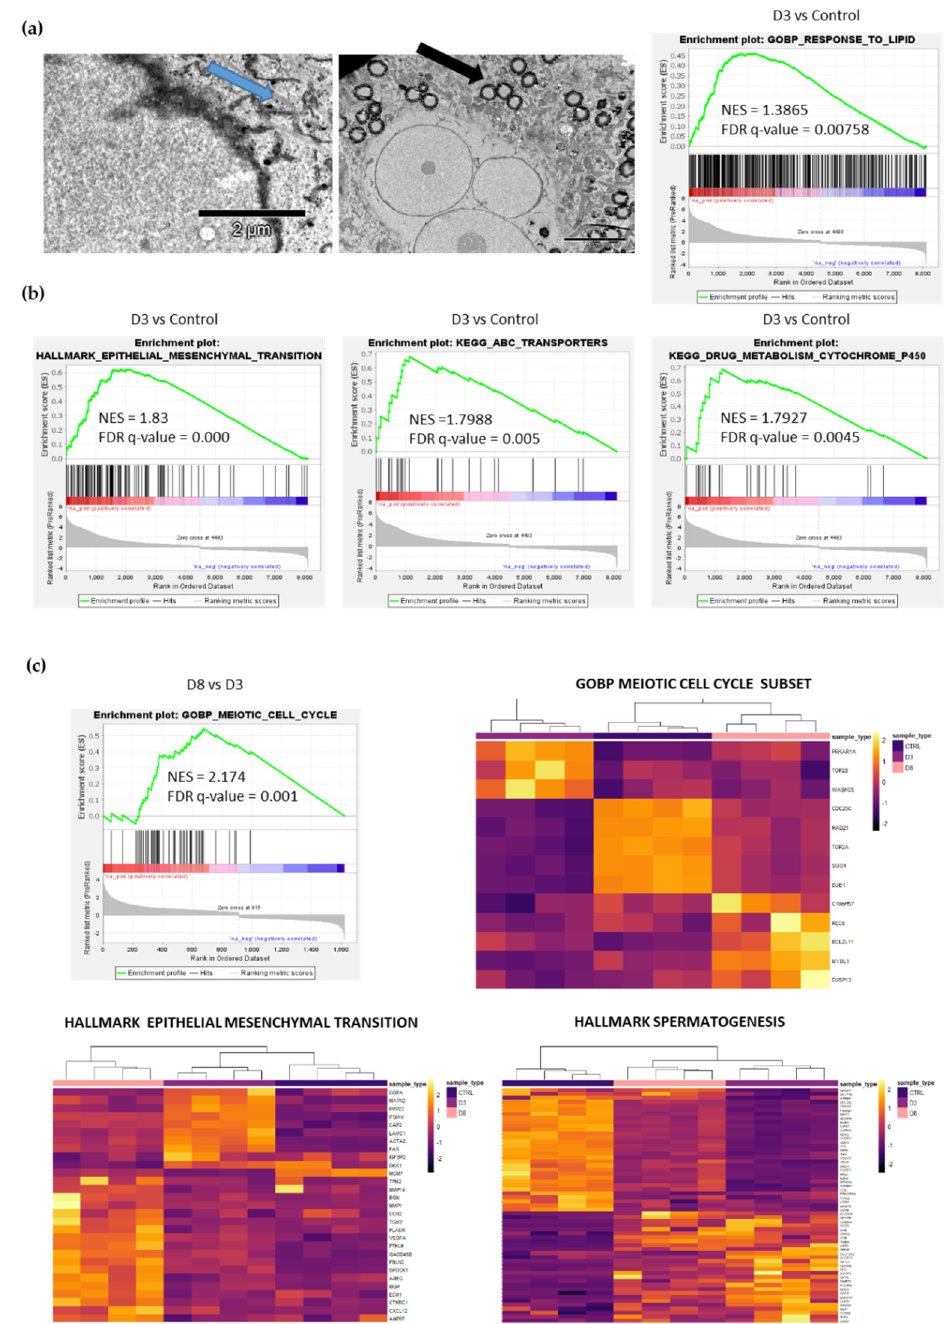
Figure 4. Transcriptome changes during escape from TIS. ( a ) Representative images of glycogen (left panel, blue arrow) and lipid droplets (right panel, black arrow) of IRI-treated senescence MCF-7 cells. Pictures were taken with the use of transmission electron microscope. GSEA analysis of the MCF-7 cells transcriptome on D3 compared to control after IRI. Positive enrichment in the indicated GOBP (gene ontology biological processes) pathway is shown. ( b ) GSEA analysis of the MCF-7 cells transcriptome on D3 compared to control after IRI treatment. Positive enrichment in indicated KEGG and HALLMARK pathways is shown. ( c ) GSEA analysis of the MCF-7 cells transcriptome on D8 compared to D3 after IRI treatment. Positive enrichment in the indicated GO pathway is shown. Heatmaps representing GOBP Meiotic Cell Cycle, HALLMARK EPITHELIAL MESENCHYMAL TRANSITION and HALLMARK SPERMATOGENESIS were prepared on differentially expressed genes from the respective gene